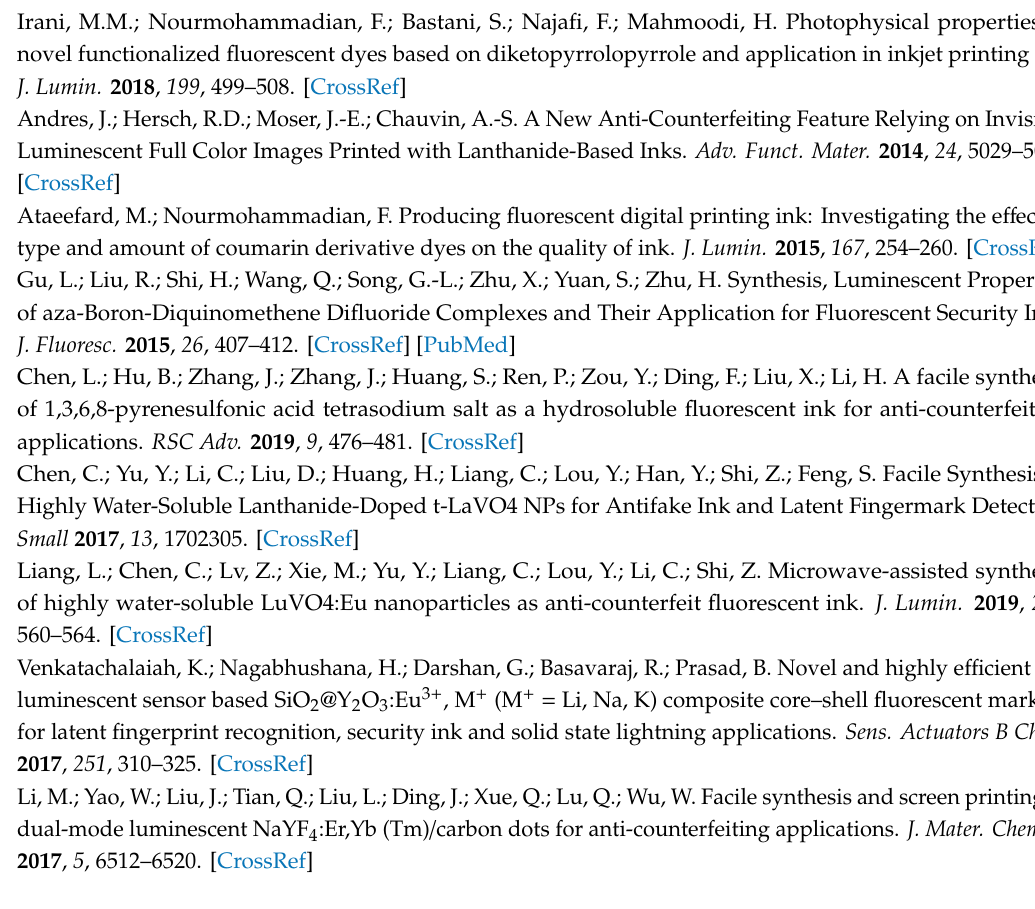
Figure S1: FT-IR spectra of (a) PTSA, (b) the product of PTSA-SiNPs prepared with PDADMAC, and (c) the product of PTSA-SiNPs prepared without